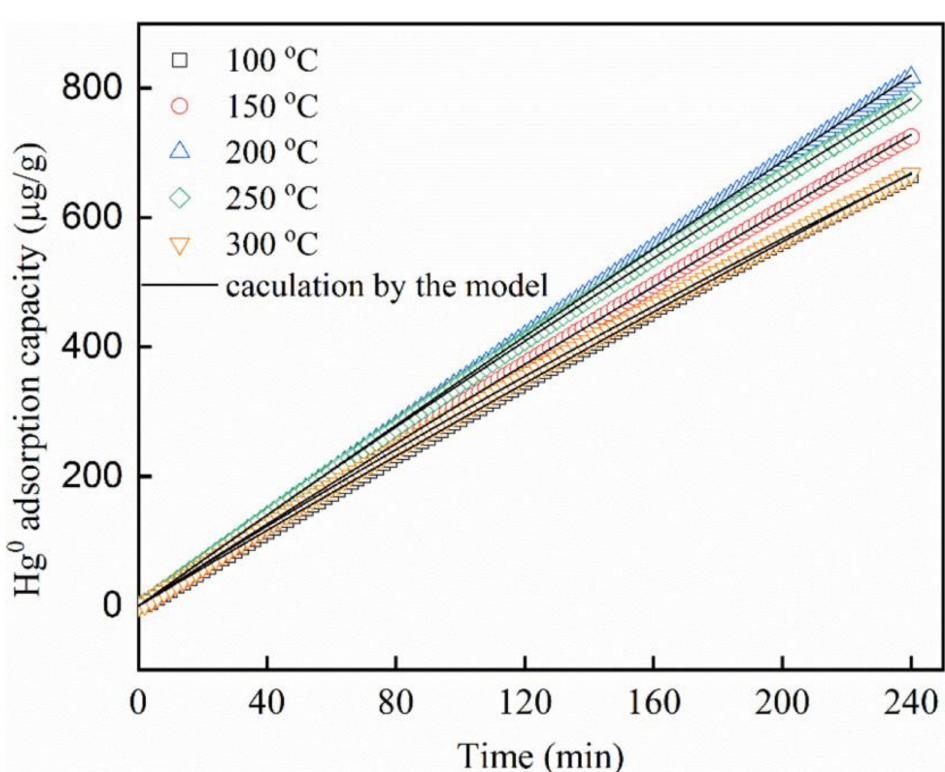
Figure 14. Simulation of Hg 0 adsorption on MIL-101(Cr) by the pseudo-second-order model. Re- action conditions: N 2 + 5% O 2 , inlet concentration of Hg 0 = 203 µ g m − 3 , gas hourly space velocity (GHSV) = 8 × 10 5 h − 1 , 200 ◦ C (reproduced with the permission from Ref